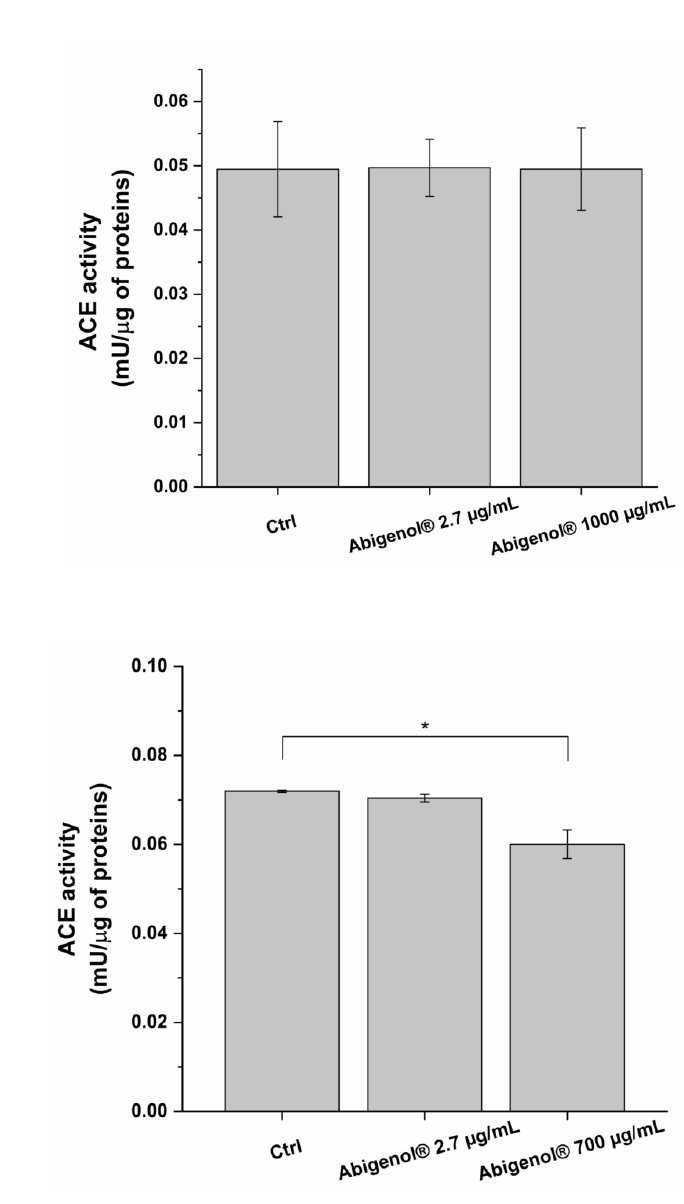
Figure 12. Effect of the silver fir extract on ACE activity in HUVEC ( A ) and H9c2 ( B ). Data were normalized on total proteins present in samples. Lisinopril was used as a control for ACE inhibition. Ctrl: control (untreated cells). * p < 0.05. (n = 3).